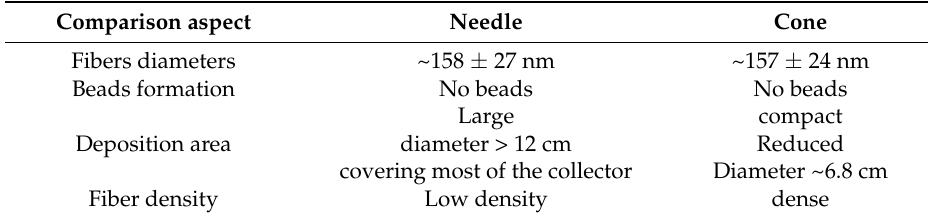
Table 5. Summary of performance for the two studied spinnerets.